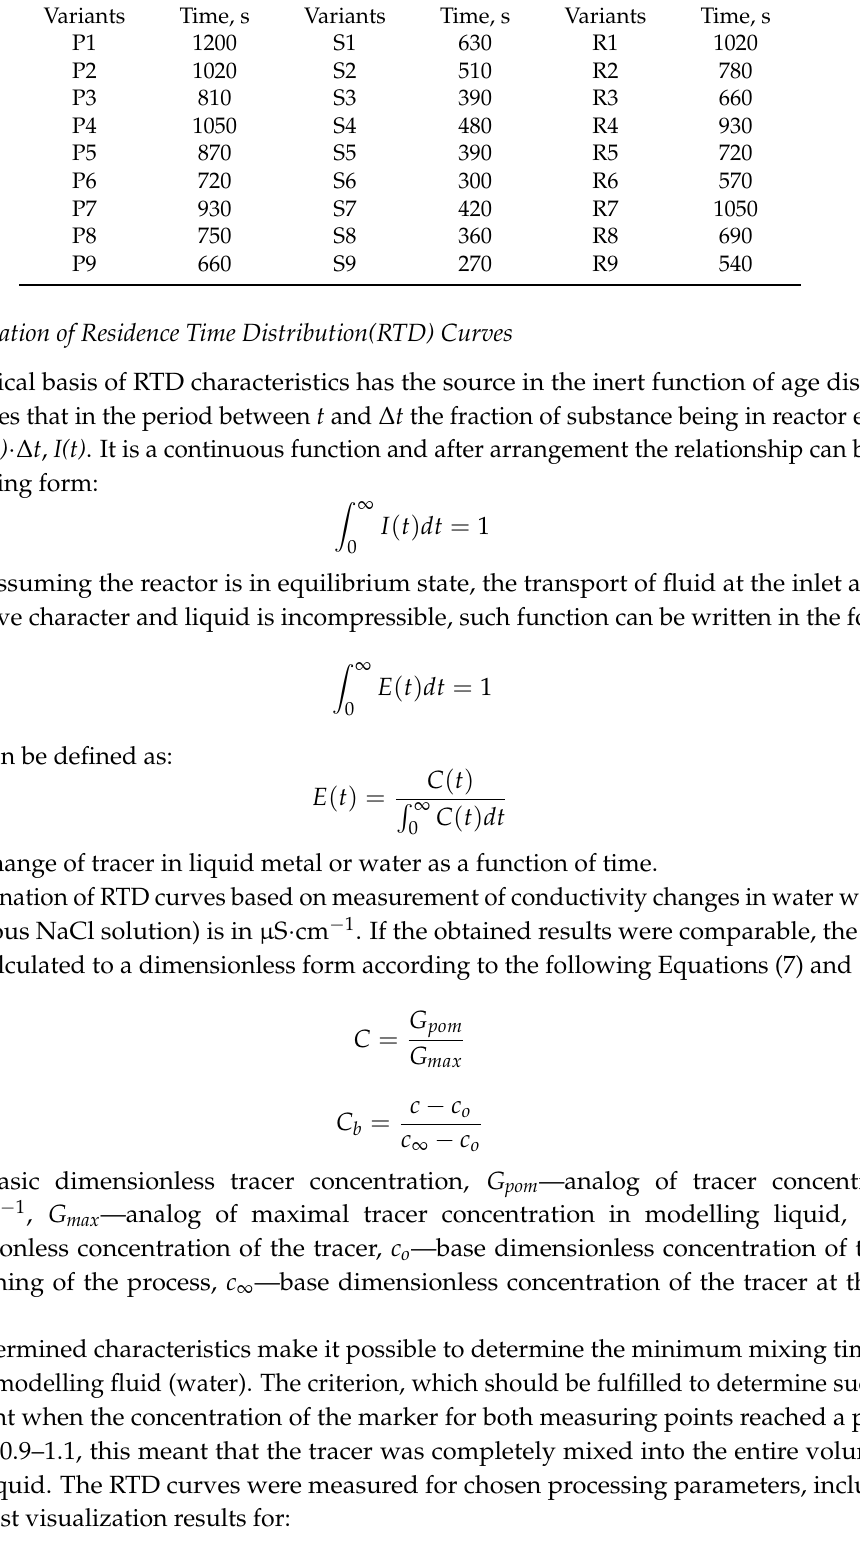
Table 5. Total time needed to eliminate 90% of dissolved oxygen for chosen variants of rotary impellers. Rotary Impeller A Rotary Impeller B Rotary Impeller C Variants Time, s Variants Time,